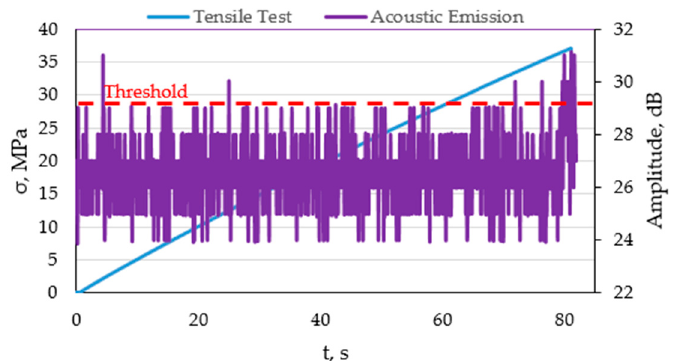
Figure 4. Graphs of amplitude plotted on graphs of tensile versus time for a selected sample based on pure polyester resin.